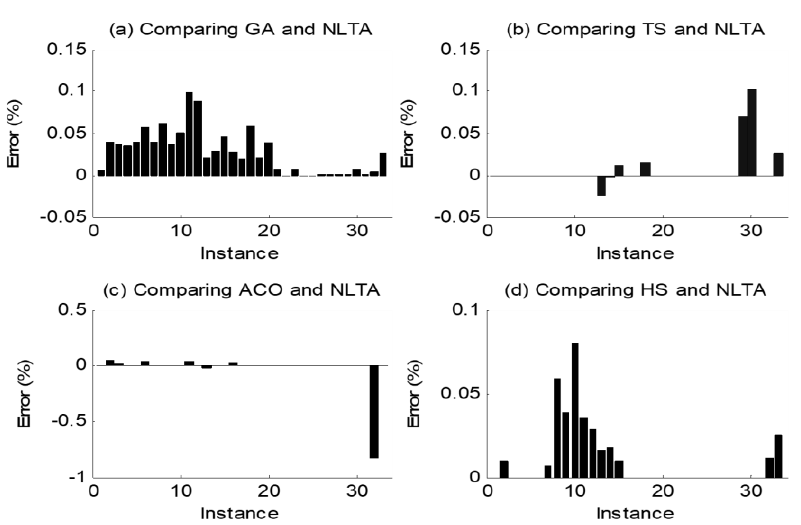
Figure 2. Comparing NLTA and four other